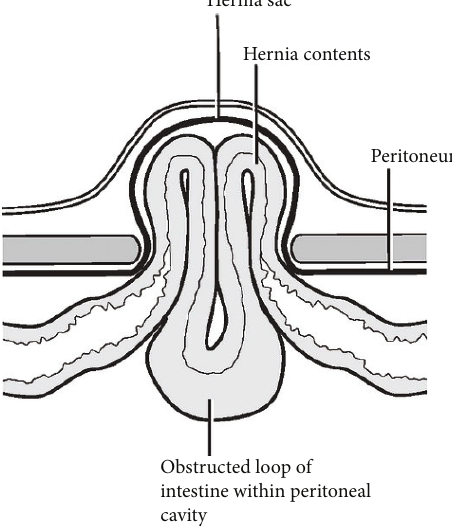
Figure 2: Schematic diagram of Maydl’s hernia (strangulated intestine at apex of